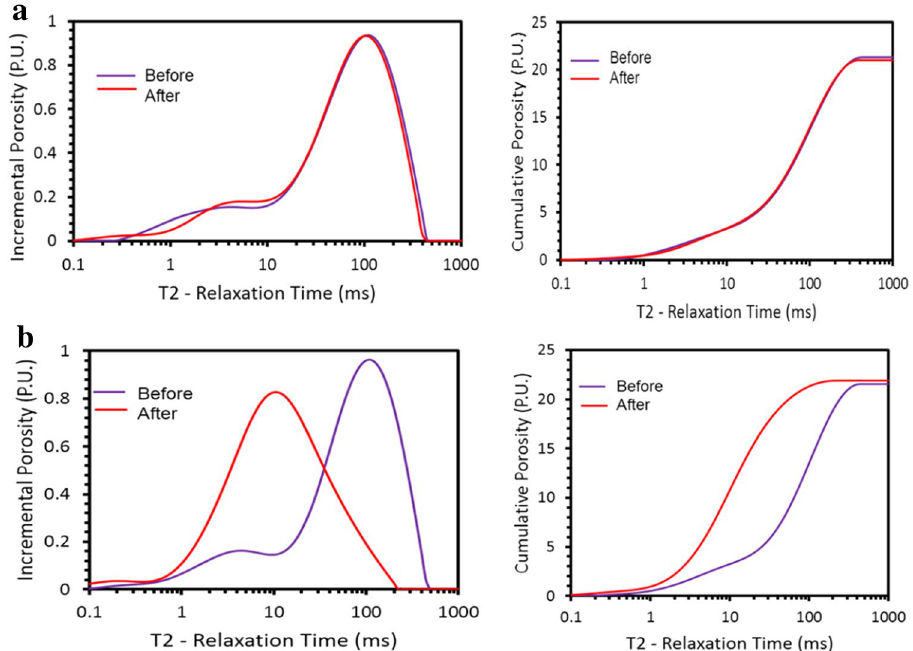
Fig. 7 a NMR T2 response curve for Bandera Grey core before and after damage at 25 °C using water as a damag- ing fluid. b NMR T2 response curve for Bandera Grey core before and after damage at 25 °C using HCl as a damaging fluid